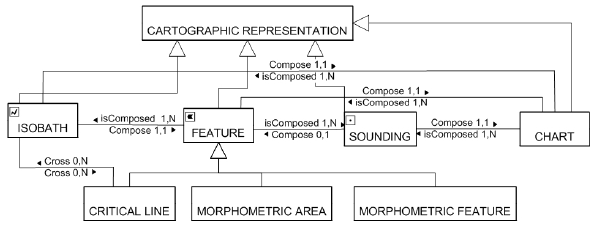
Figure 6: Chart elements in the method ontology where features from the IHO correspond to the most specialised concepts at the bottom of the hierarchy, and other concepts are obtained by generalisation. For example, the Seamount and the Hill defined in the IHO terminology are generalised as Peak Fea- ture which gathers all features whose vertical profile is a peak and, at the next level, the Peak Feature and Ridge Feature are generalised into Eminence Feature whose vertical profile is an eminence. By this way, the granularity can be adjusted according to the accuracy of input data or the requirements of the applica- tion. For a full review of the feature description and hierarchy, the ontology is accessible online 3 .